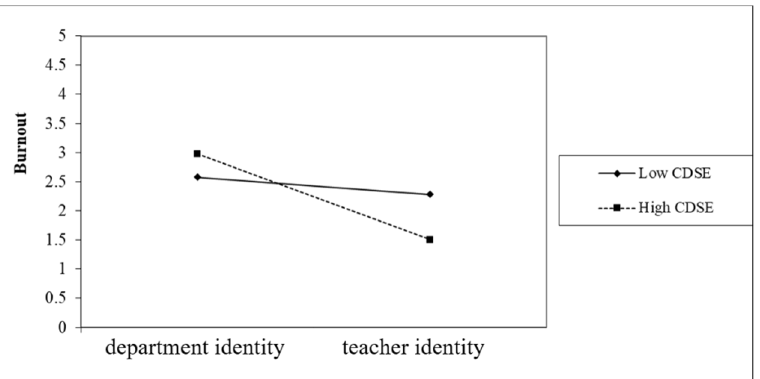
Figure 6. The moderation effect of the profession identity of preservice teachers with action control on CDSE and burnout.